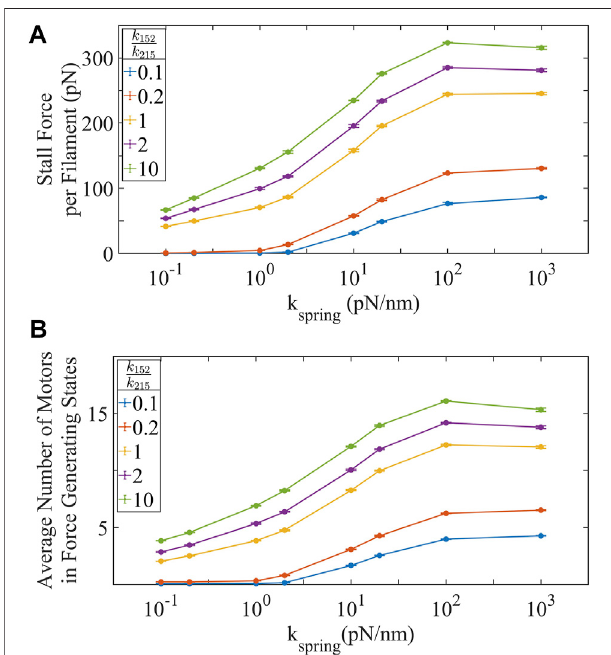
FIGURE 2 | (A) Stall force, the maximum force an actin-myosin fi ber can generate increases with ppMLC2:MLC2 and substrate stiffness. (B) The number of motors actively generating force increases with ppMLC2:MLC2 and substrate stiffness. Our simulations show that approximately one quarter or less of available motors are actively in the force generating state at anygiveninstant,evenforlargestallforces.Errorbarsrepresent±SEMfor100 fi laments over three independent